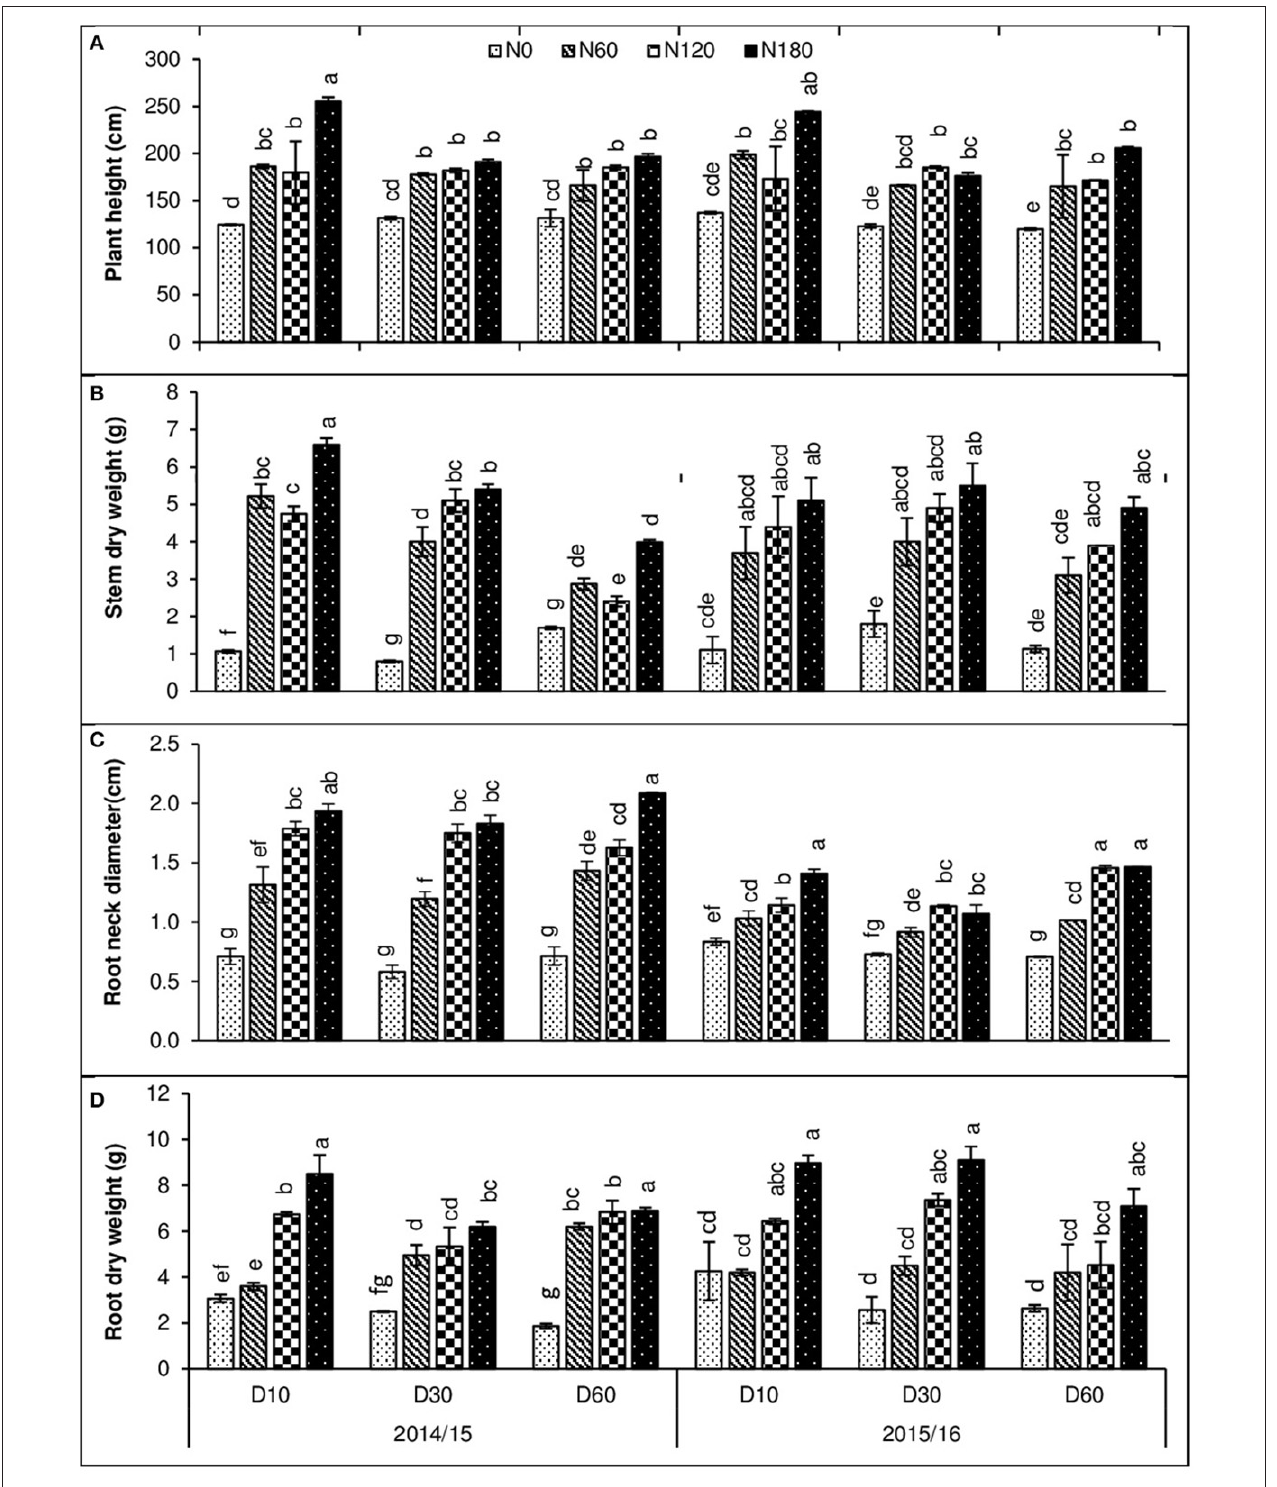
FIGURE 1 | Effect of plant densities (10, 30, and 60 plants m − 2 ) and N rates (0, 60, 120, and 180kg ha − 1 ) on rapeseed, (A) plant height, (B) shoot dry weight, (C) root neck diameter, and (D) root dry weight in two consecutive growing seasons (2014/15 and 2015/16). Error bars indicate standard errors. Different letters indicate significant differences at p <